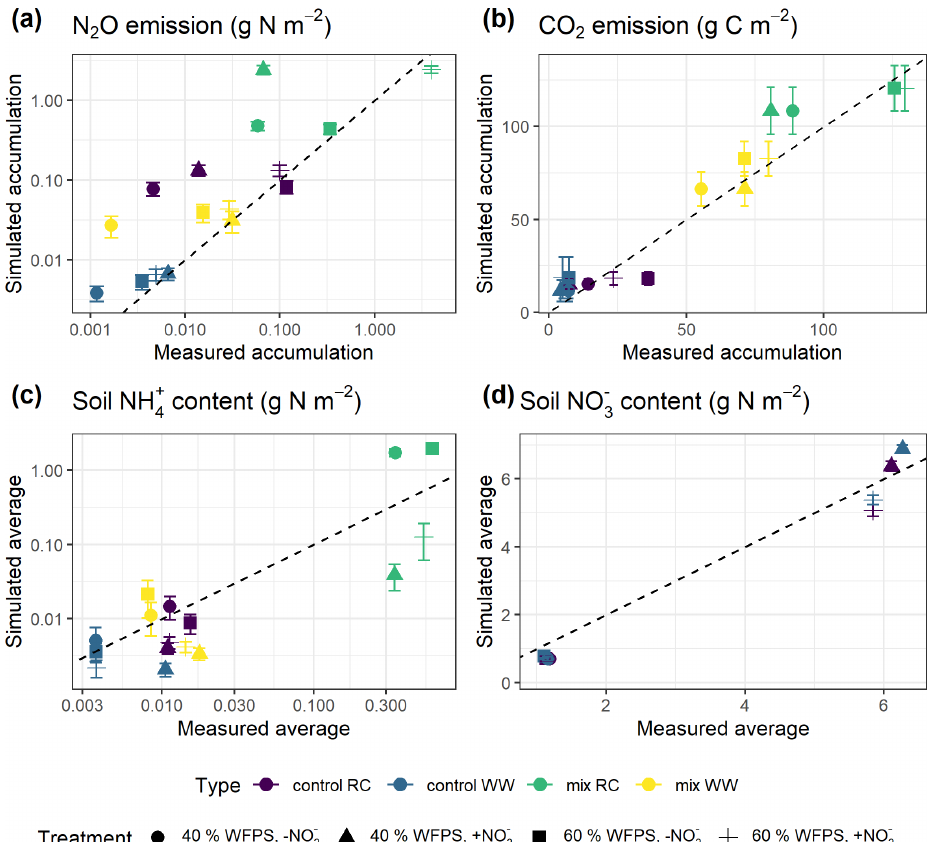
Figure 7. Simulated and measured (a) cumulative N 2 O fluxes, (b) cumulative CO 2 fluxes, (c) average NH + soil NO − content during the 43d incubation (error bar: 95% confidence interval). Simulated results were obtained from multi-treatment 3 calibration. Colors indicate different types of residue amendment, and markers indicate different abiotic soil environments. Reference lines with a slope of 1.0 are shown on the